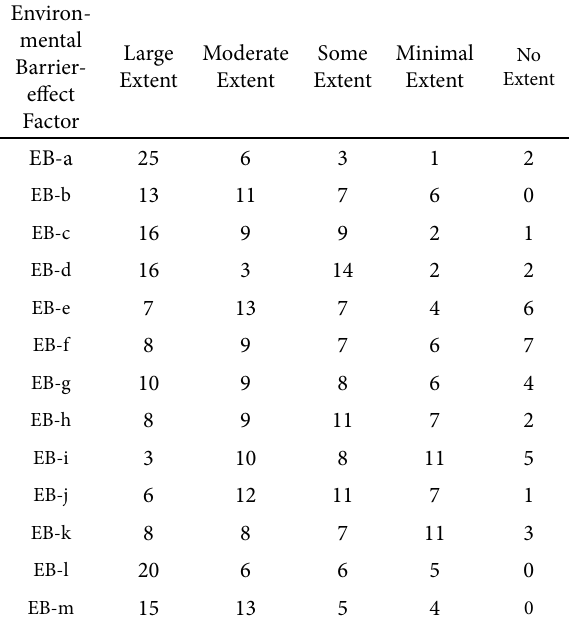
Table 3. Frequency distribution of participant responses to the barriers of implementing EMS in the Nigerian construction